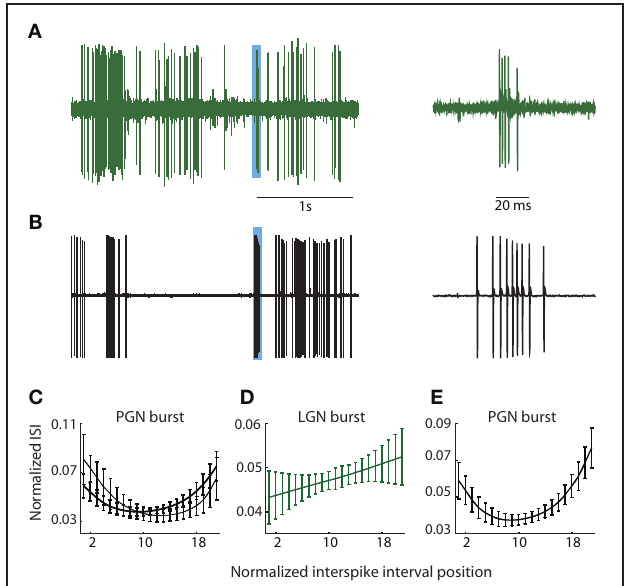
FIGURE 1 | PGN and LGN burst classification. (A,B) Sample traces recorded from one cell in the LGN (A) and another in the PGN (B) depicting tonic and burst spikes, left ; the regions shaded blue indicate bursts that are shown at an expanded timescale at right . Bursts in the LGN are composed of decelerating spike trains whereas bursts in PGN comprise accelerating and decelerating spike trains. (C) ISI distributions from two cluster means of bursts obtained from seven randomly selected cells in the PGN; the interval between successive spikes first shortened and then increased to form a U-shaped curve. (D) The cluster mean for the sole cluster formed for bursts in the LGN; the ISI grew longer with each successive spike. (E) U-shaped cluster mean obtained after pooling events (detected with criteria that identify bursts in the PGN) from seven cells each in the LGN and PGN; all spikes within the cluster came from the